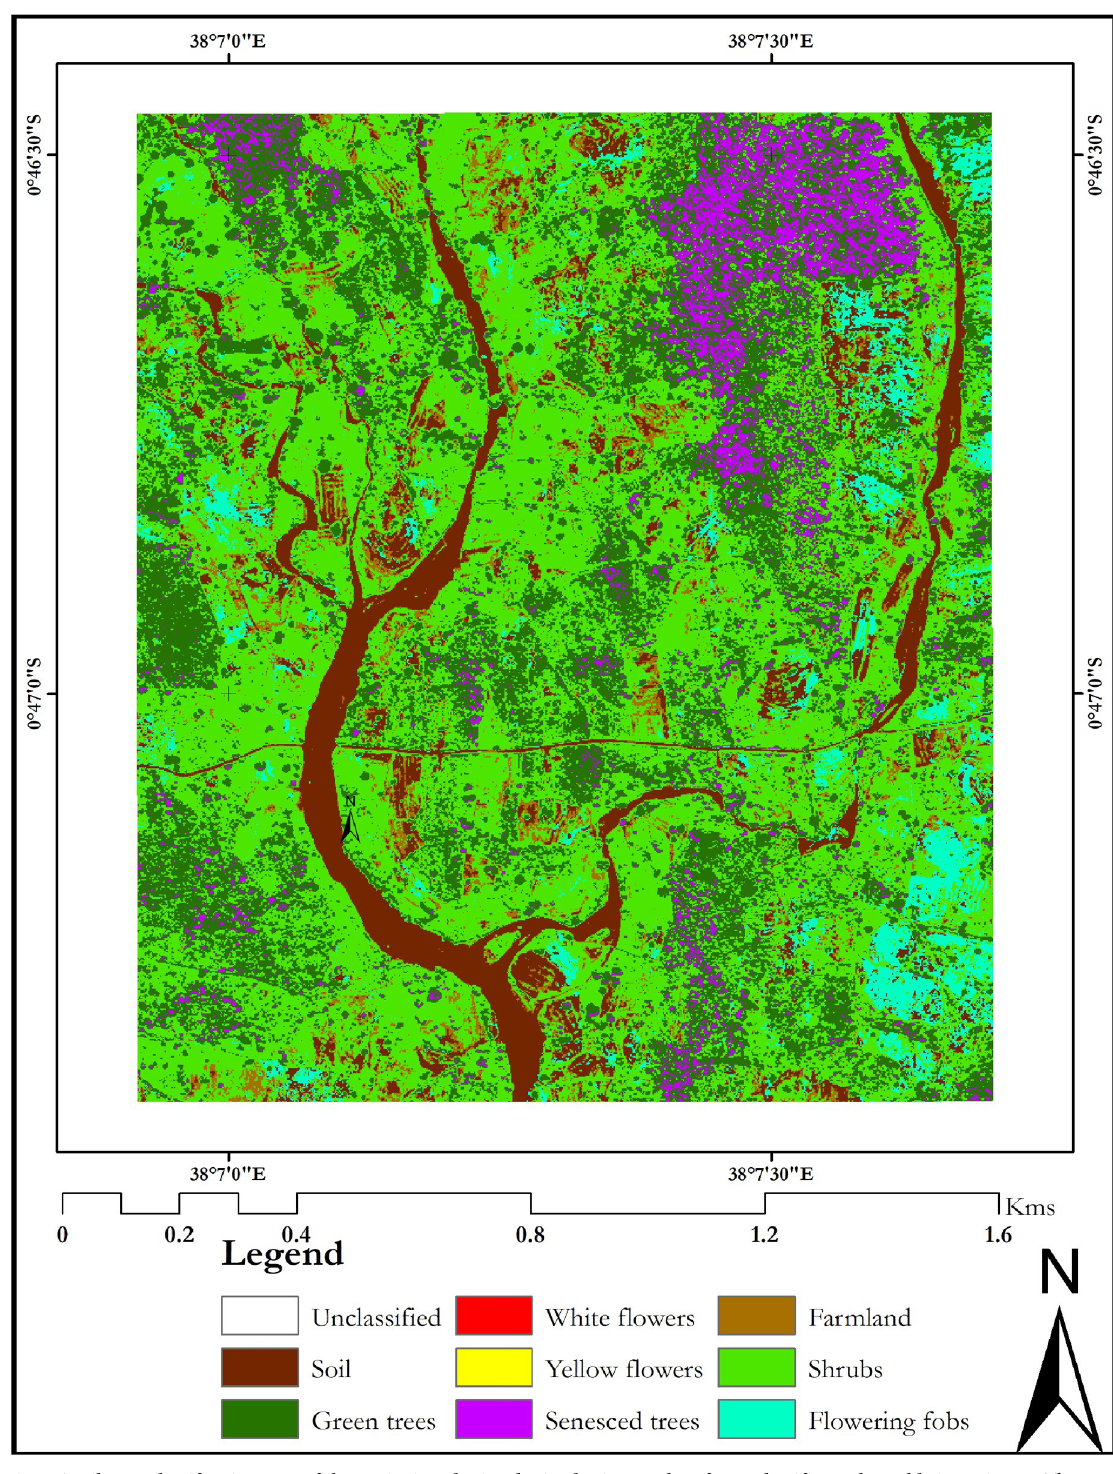
Fig 4. April 2014 classification map of the Mwingi study site obtained using random forest classifier and WorldView-2 image. The map was developed using QGIS software version 3.10 ( https : //qgis . org/en/site/ )[52].